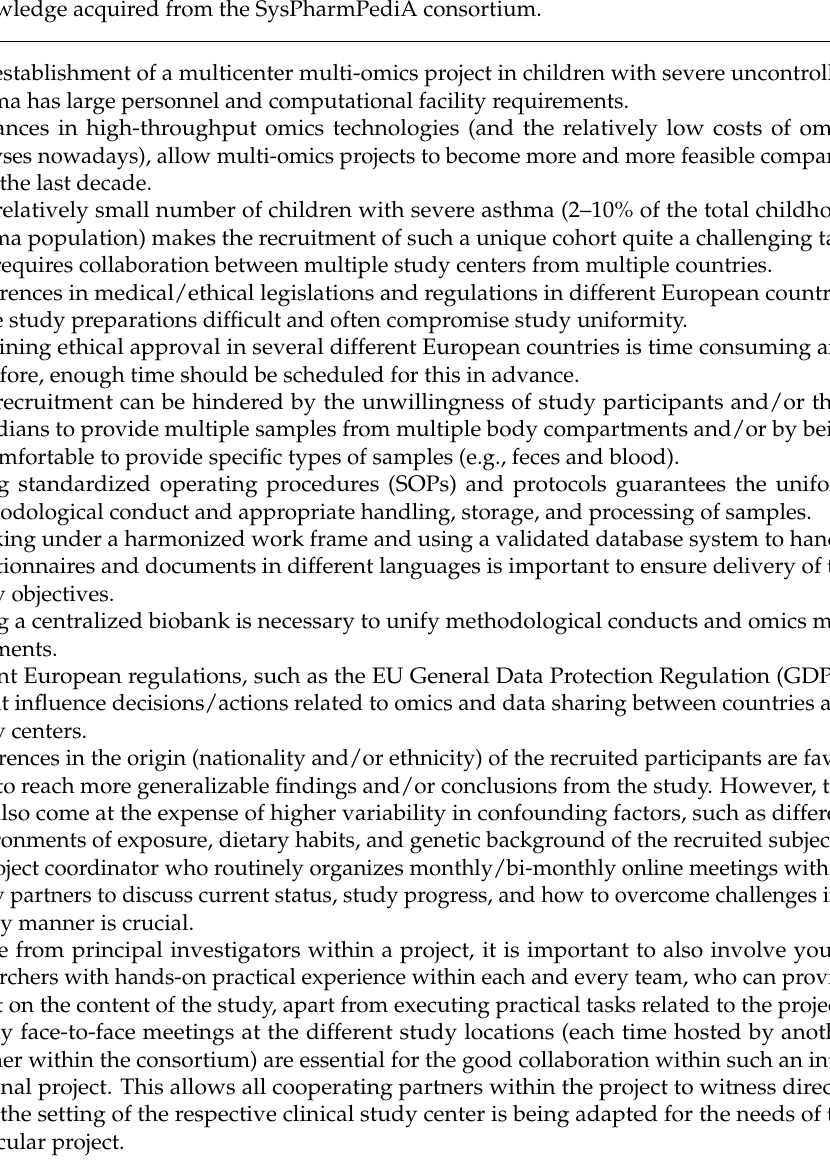
PediA cohort. Table S1: List of the aero- and food-allergens tested by the skin prick test (SPT) and/or specific IgE for diagnosis of atopy in the recruited subjects, Table S2: Summary of different omics platforms and technologies used in the SysPharmPediA study, Table S3: Baseline characteristics for the STOPPA study participants that follow the eligibility criteria by the SysPharmPediA